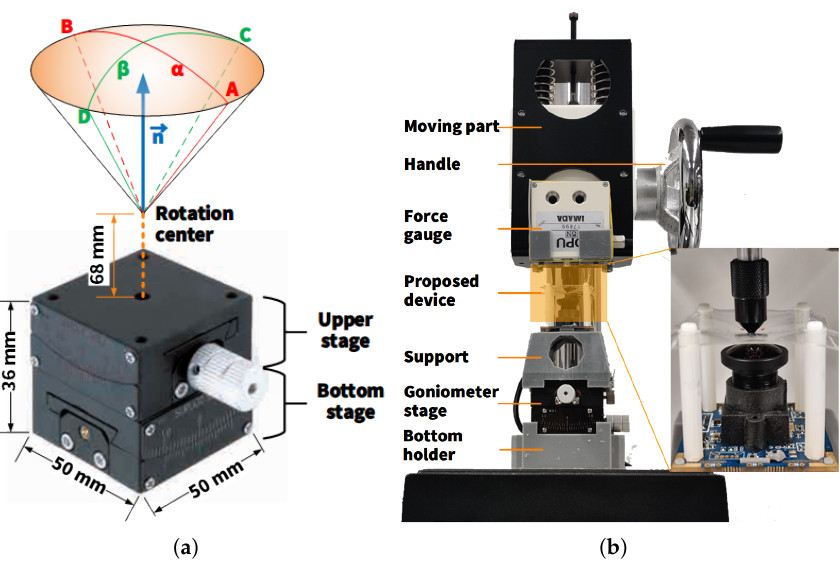
Figure 10. Experiment platform. ( a ) A two-axis goniometer stage, and ( b ) an overview of the whole experimental platform.